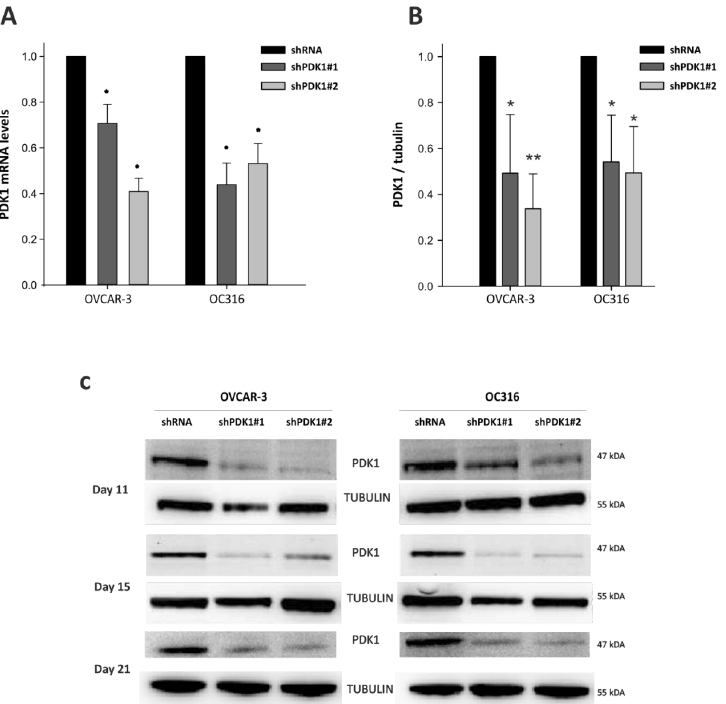
Figure 1. Decreased expression of Pyruvate dehydrogenase kinase 1 (PDK1) at mRNA and protein levels. OVCAR-3 and OC316 cell lines were transduced by lentiviral vectors encoding PDK1-targeting shRNA (shPDK1#1 and shPDK1#2). ( A ) PDK1 mRNA expression levels were analyzed by real-time PCR, * p < 0.05 Mann–Whitney. ( B ) PDK1 protein expression levels were quantified by